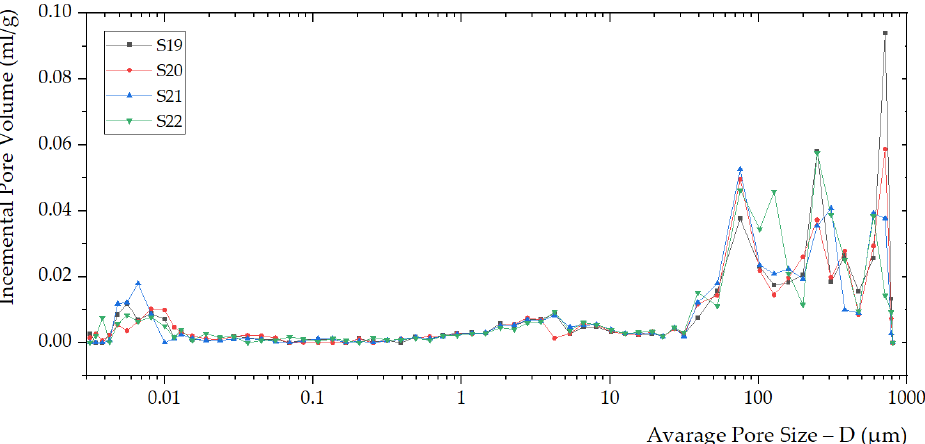
Figure 4. Porosity distribution within the foamed geopolymer foams S19, S20, S21, and S22 was identified through the average pore size (D) versus incremental pore volume.